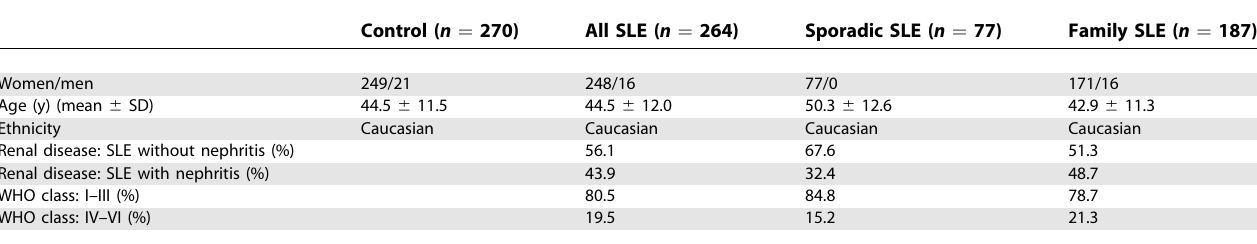
Table 3. Characteristics of SLE Patients and